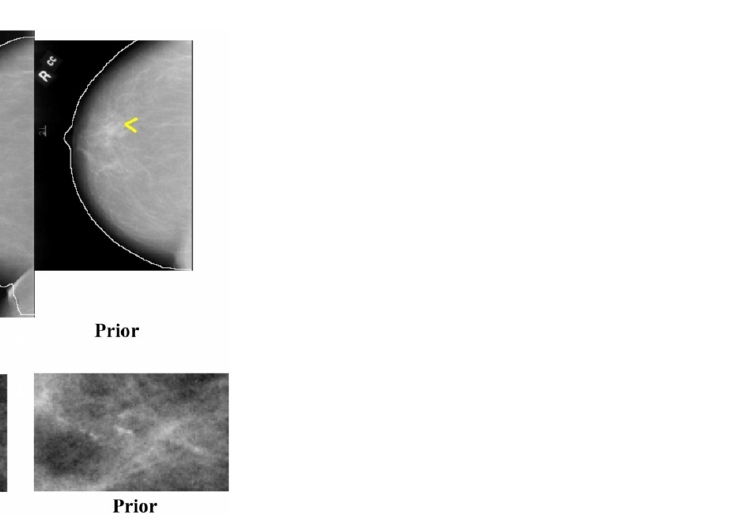
Figure 6. Temporally sequential mammograms containing MC clusters. ( a ) Current and prior mammograms with automatically detected breast boundaries, ( b ) A close-up of the current and prior views of the MC cluster (reprint with permission from [40]).